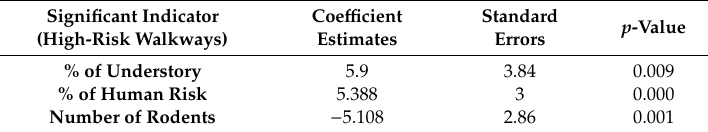
Table 3. Multinomial logistic regression results for significant